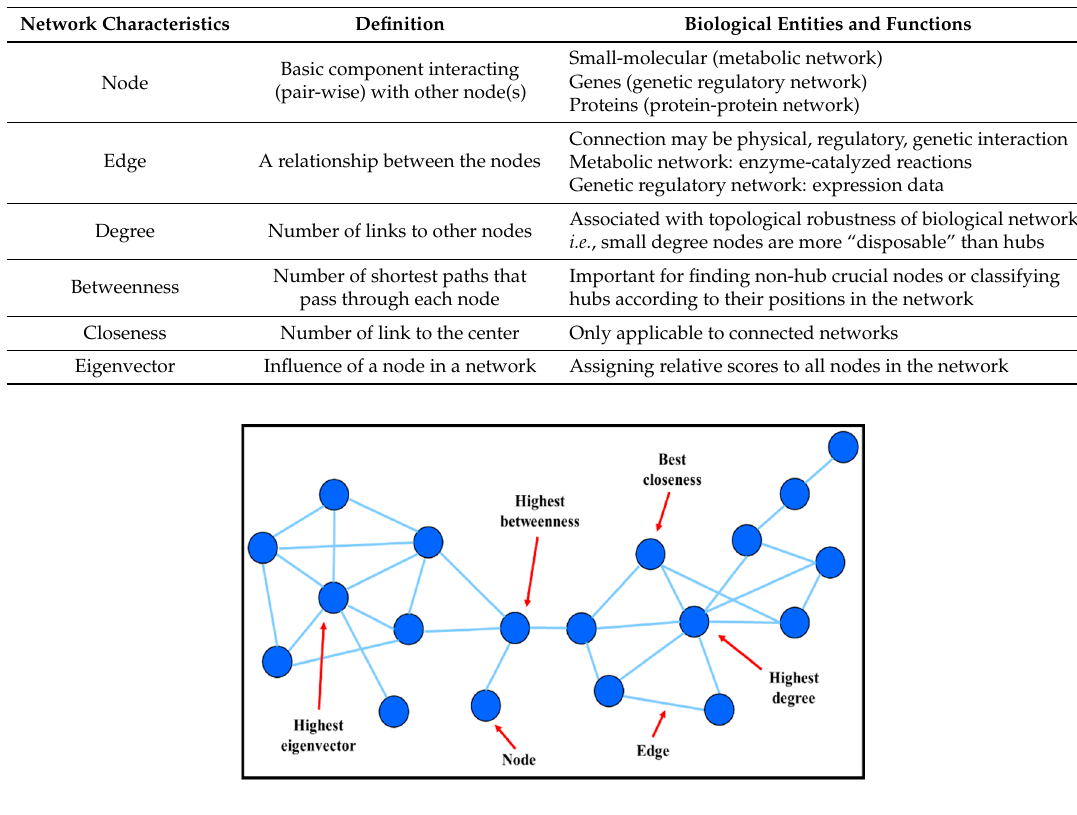
Table 2. Important topological characteristics in static network.